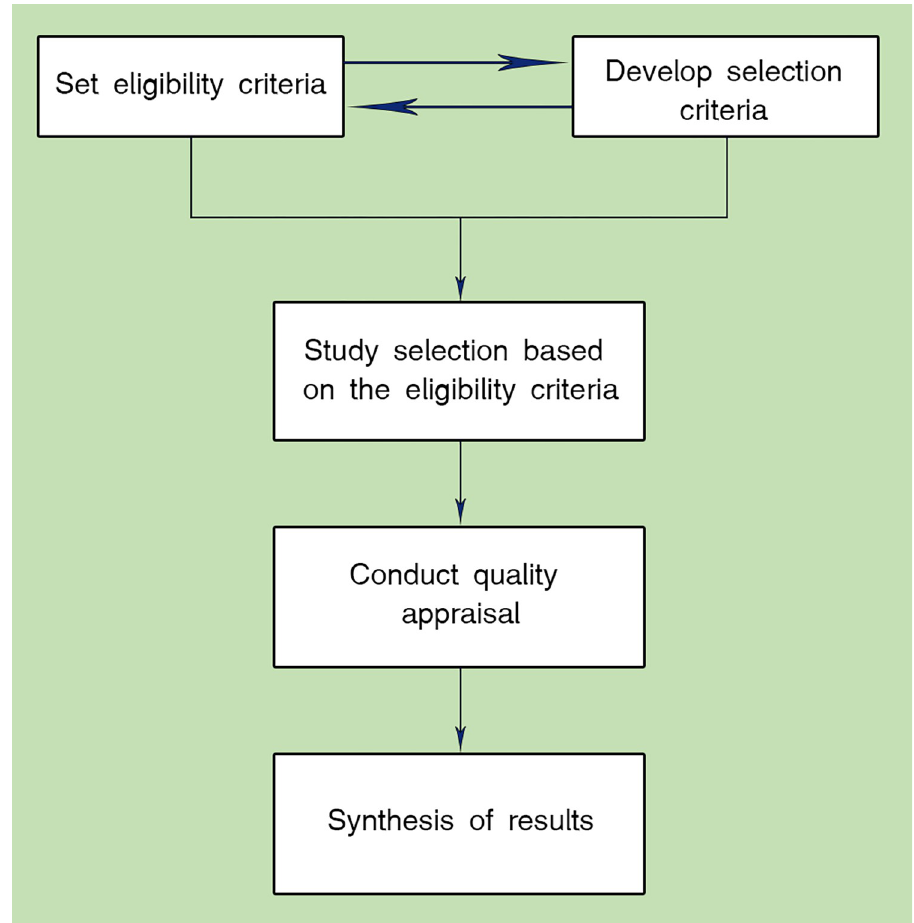
Fig 1. This flowchart shows the methodology followed in the systematic